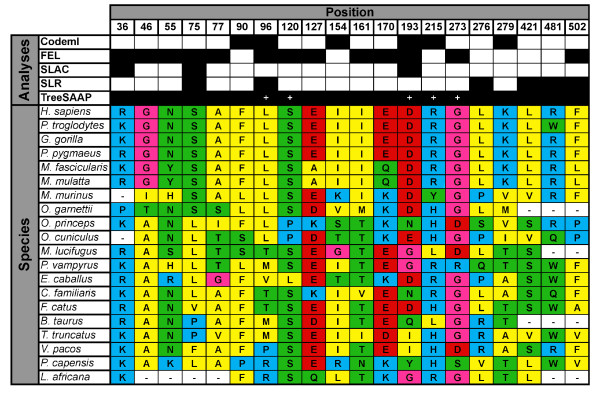
Amino acids in the same evolutionary positions showing strong signatures of selection at the amino acids and the nucleotide level. Sites under positive selection confirmed by the different models used in this study for the dataset of 20 species (excluding rodents). The sites were numbered according to the Homo sapiens position [EMBL:ENST00000361056]. The results for SLAC, FEL, PAML (Model 8), TreeSAAP (at least one property under selection) and SLR are marked with a black box in the sites showing positive selection. The sites with more than three properties under selection in TreeSAAP are marked with a white plus symbol. The background colors represent the amino acids properties: polar positive (blue), polar negative (red and green), non-polar aliphatic (yellow), and P and G (pink).